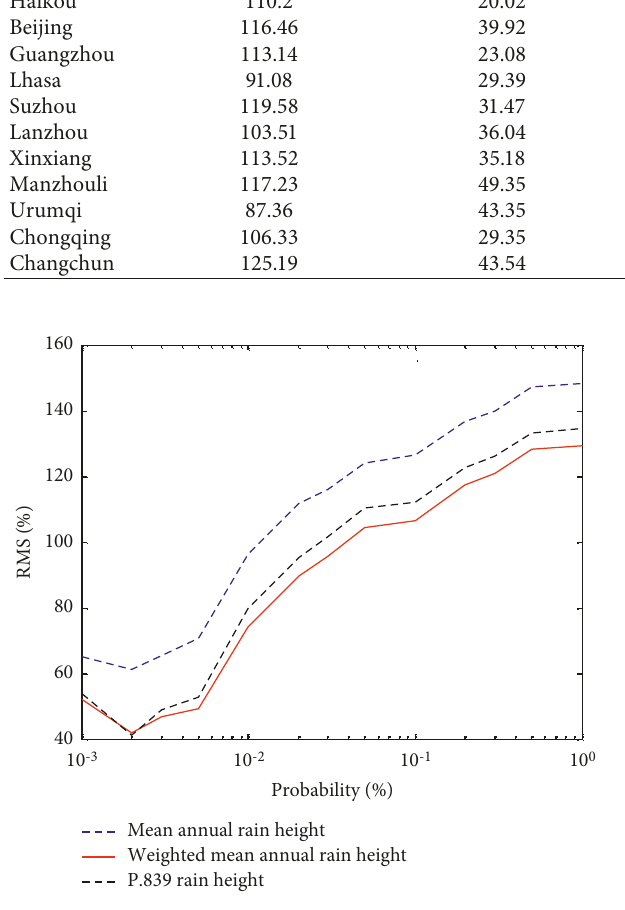
Figure 11: The comparison of rain attenuation prediction with different rain heights.